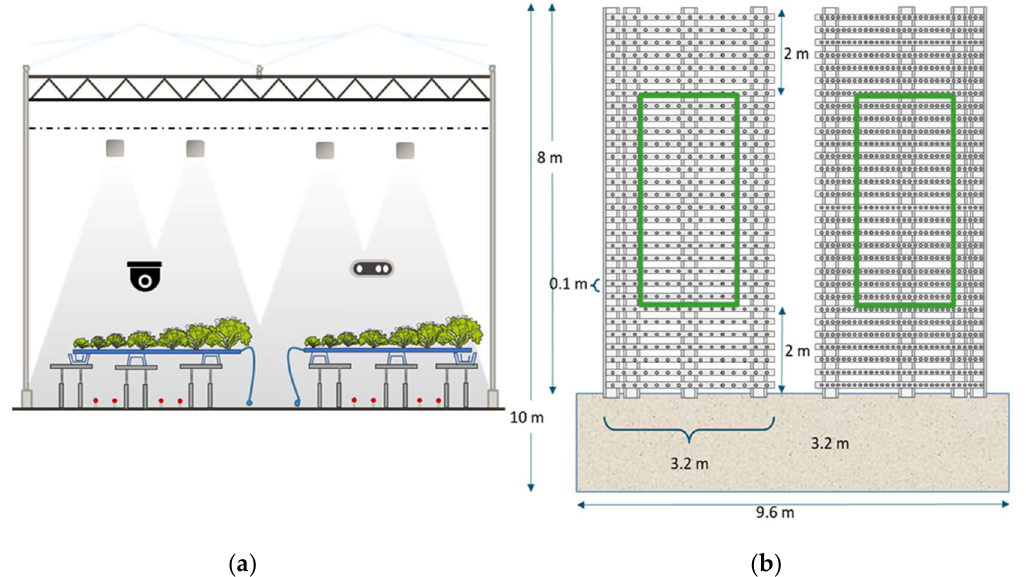
Figure 2. ( a ) Cross- and ( b ) top-view sections of one greenhouse experimental compartment with 96 m 2 ground floor. ( a ) Compartment with crop and actuators: rail pipe, irrigation system, NFT gutters, CO 2 supply, LED artificial light, and two screens. ( b ) Arrangement of lettuce gutters. Green boxes represent the harvest area for data analysis.